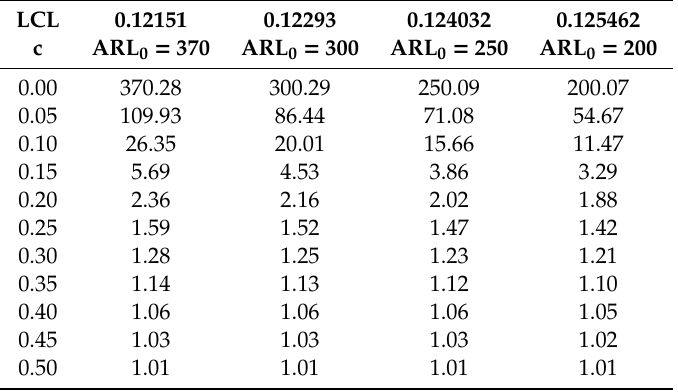
Table 11. The ARLs for the proposed chart when n = 25, GD (0.5,1.00), USL = 3.9397, and LSL = 0.0100.